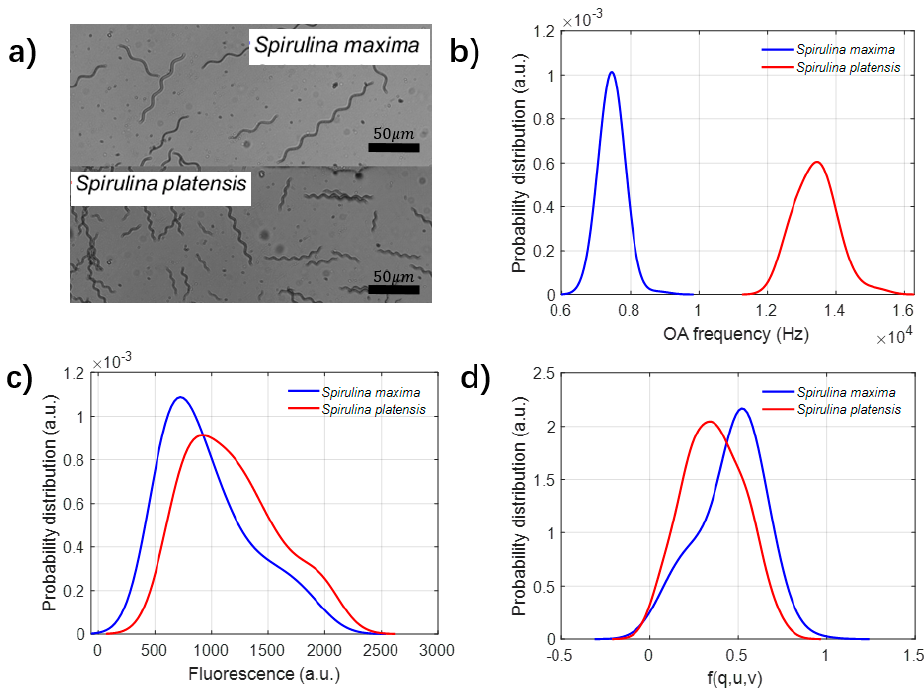
Figure 6. ( a ) The microscopic photo of Spirulina platensis and Spirulina maxima. ( b – d ) The probability distribution of acoustic frequency, fluorescence and f ( q , u , v ) .